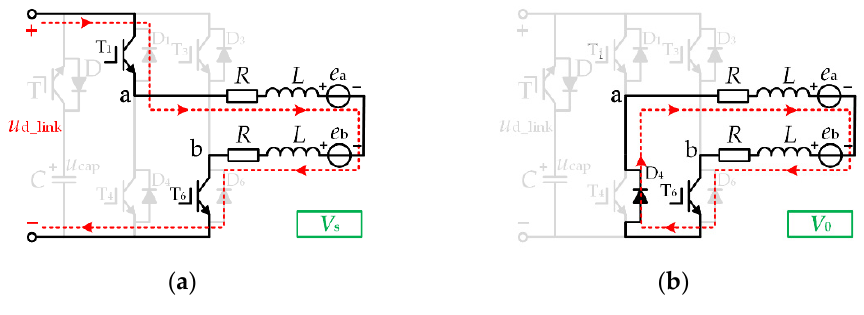
Figure 4. Vector equivalent circuit ( a ) V s ( b ) V 0 .